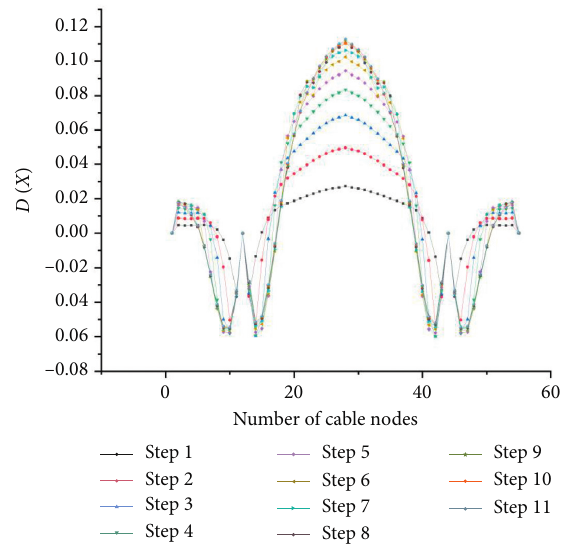
Figure 11: Vertical displacement change of the main cable for each step in tensioning stage